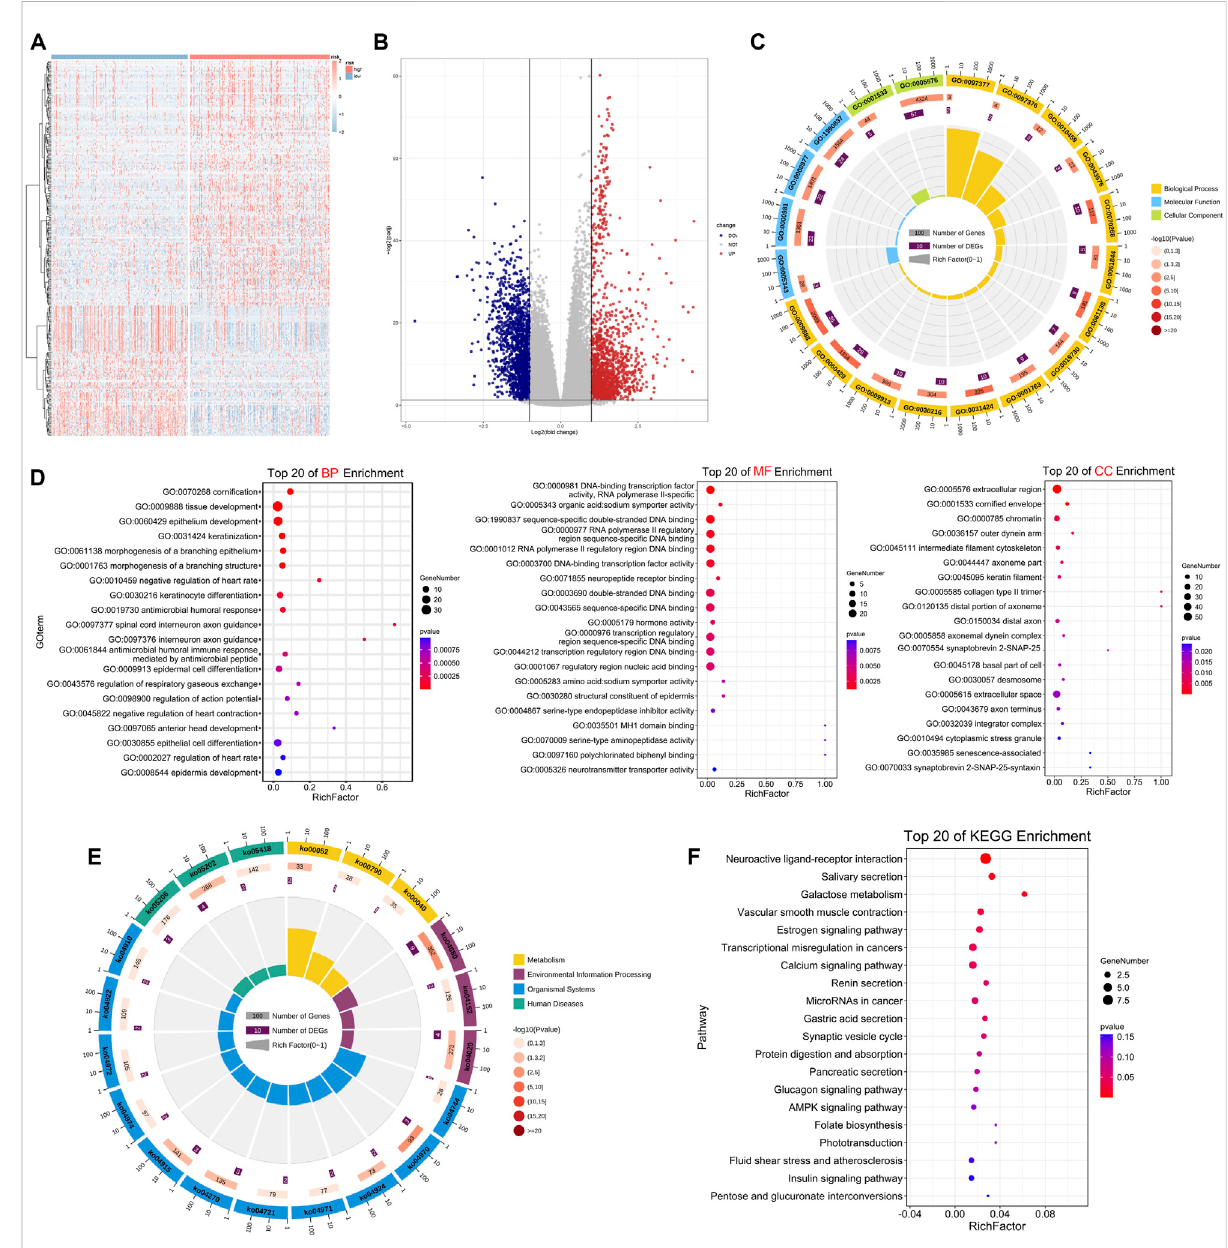
FIGURE 6 Differential expression analysis and functional enrichment analysis of the two risk groups (A,B) Heat map and volcano plot of differential expression in high-and low-risk groups (C) GO analysis of the two risk groups. Outer circle, GO term; cylindrical of inner circle, number of enriched genes; yellow, BP(BiologicalProcess); blue,MF (Molecular Function); green,CC(CellularComponent) (D) Top 20ofBP,MF, CC (E) KEGG analysis of high-and low-risk groups. Outer circle, the number of KEGG pathways; inner circle, number of enriched genes; yellow, metabolism; blue, organismal systems; green, human diseases; purple, environmental information processing (F) Top 20 of KEGG pathways